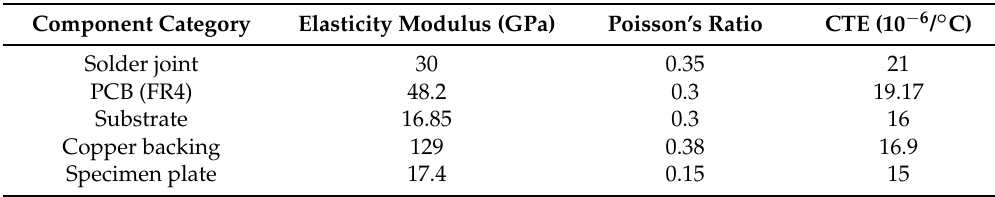
Table 2. Material attribution setting.